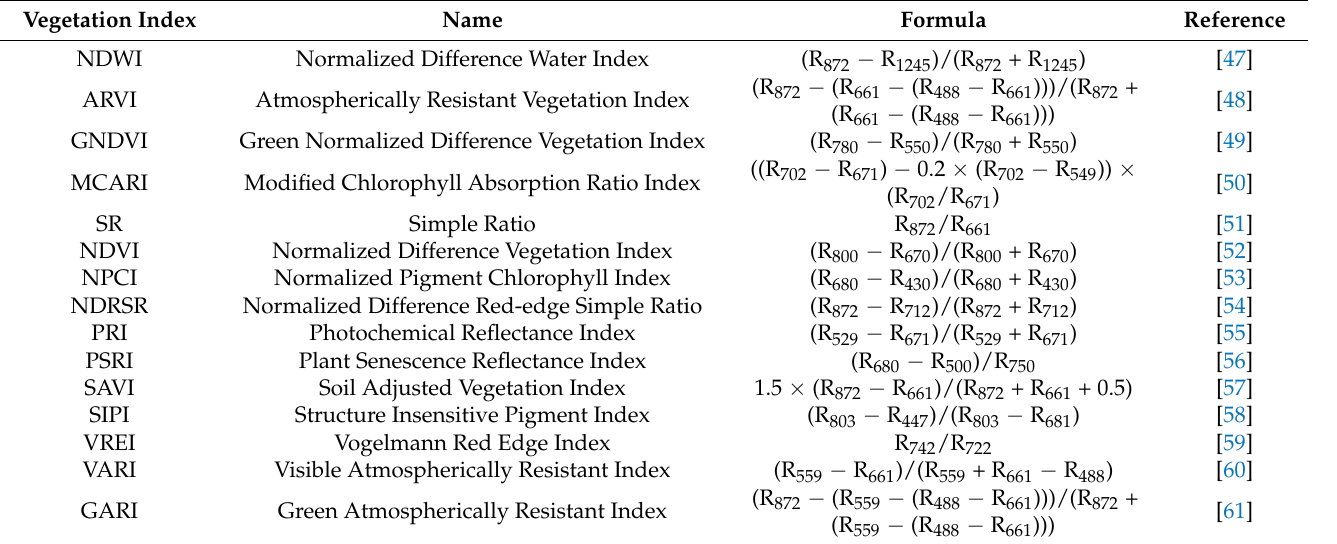
Table 1. Introduction of the Vegetation